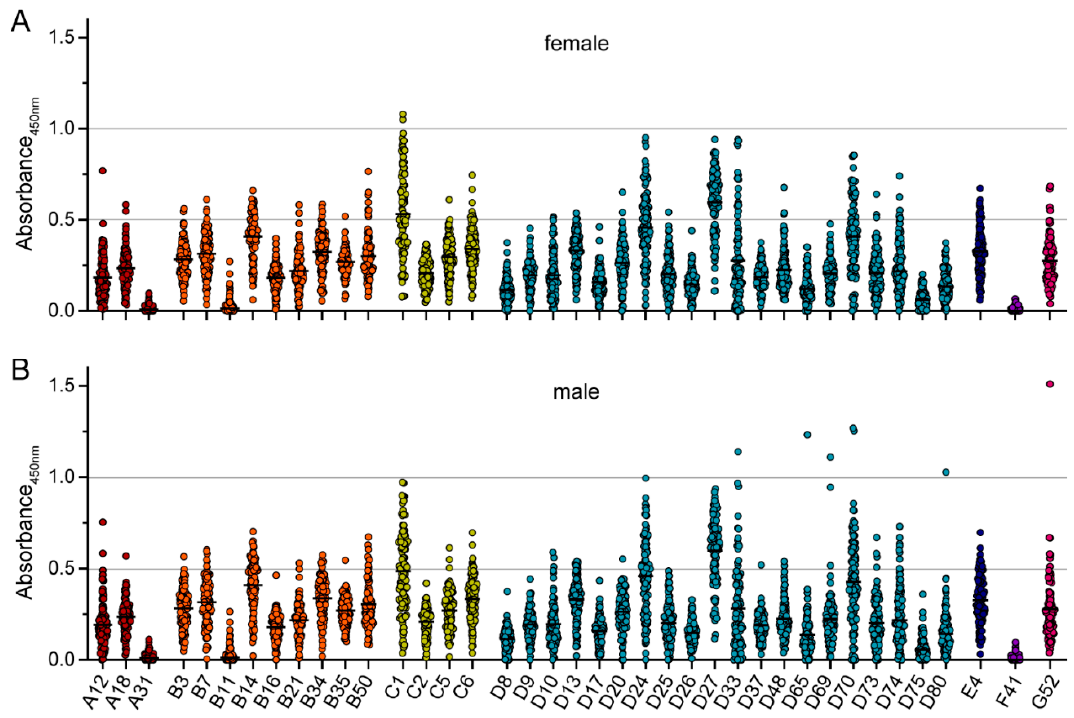
Figure 4. Binding antibody data stratified by sex of serum donors. The data presented in Figure 1 were stratified by the sex of the serum donors, showing data from 107 female ( A ) and 102 male serum donors ( B ). Each dot represents an individual sample, lines indicate mean values of all sera for the indicated HAdV type. No statistically significant differences in binding antibody levels of female and male serum donors were found using Kruskal-Wallis one-way ANOVA on ranks and Dunn’s multiple comparisons test.